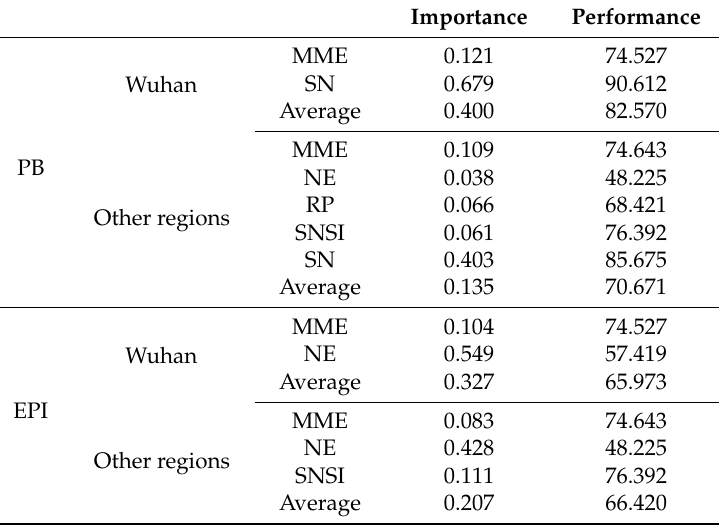
Table 9. Values of Importance and